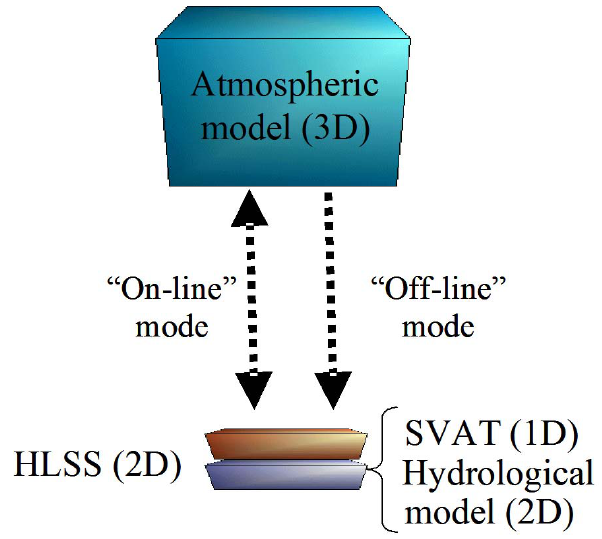
Fig. 1. A strategy for coupled atmosphere, land and hydrology mod-